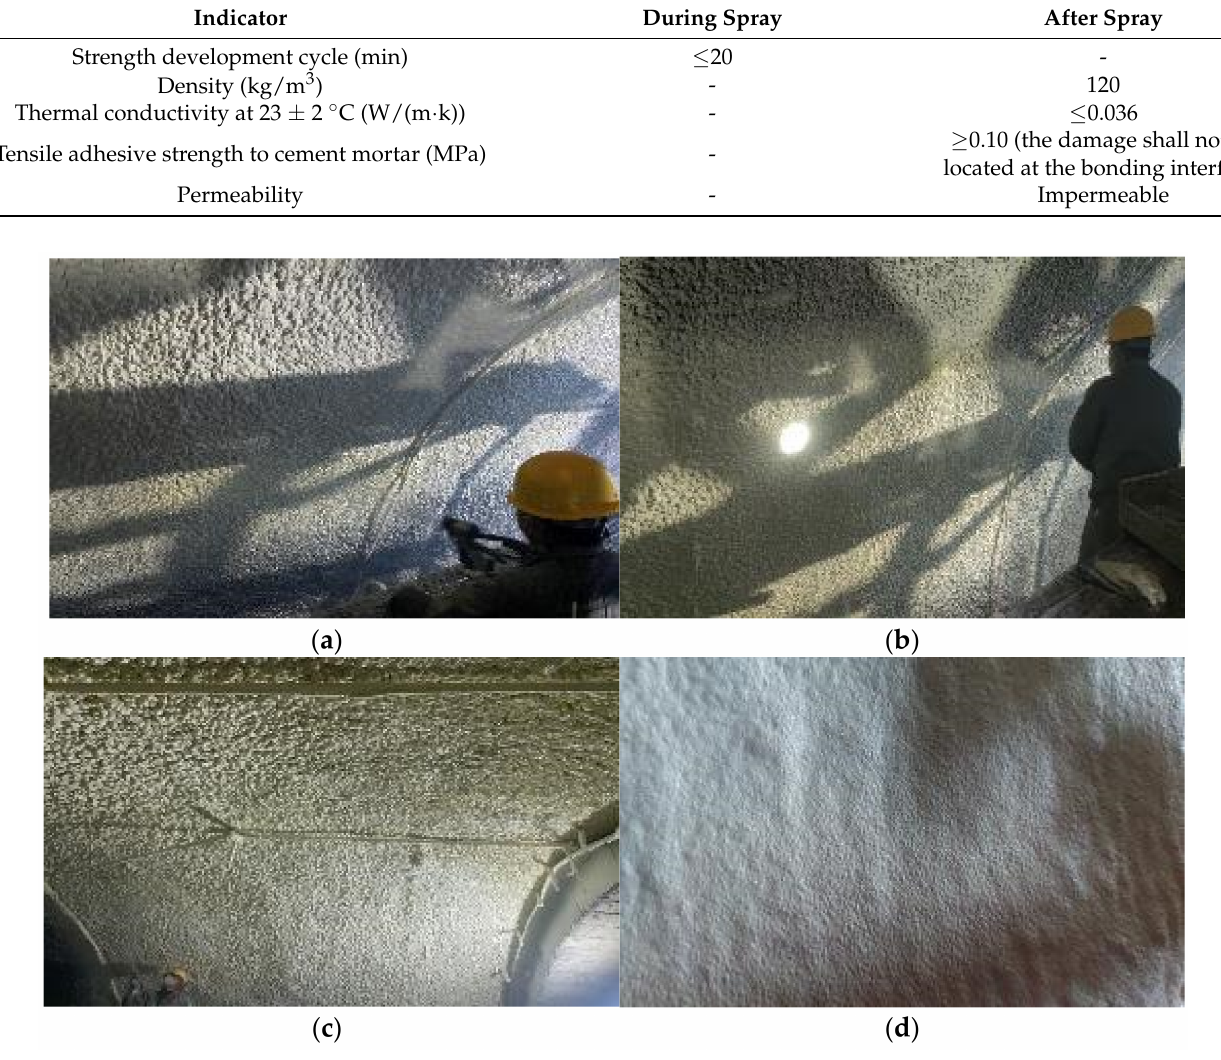
Figure 13. On-site spraying process of polymer materials and spraying effect at different positions: ( a ) spraying process of the first layer; ( b ) spraying process of the second layer; ( c ) spraying effect at the vault; ( d ) spraying effect at the arch